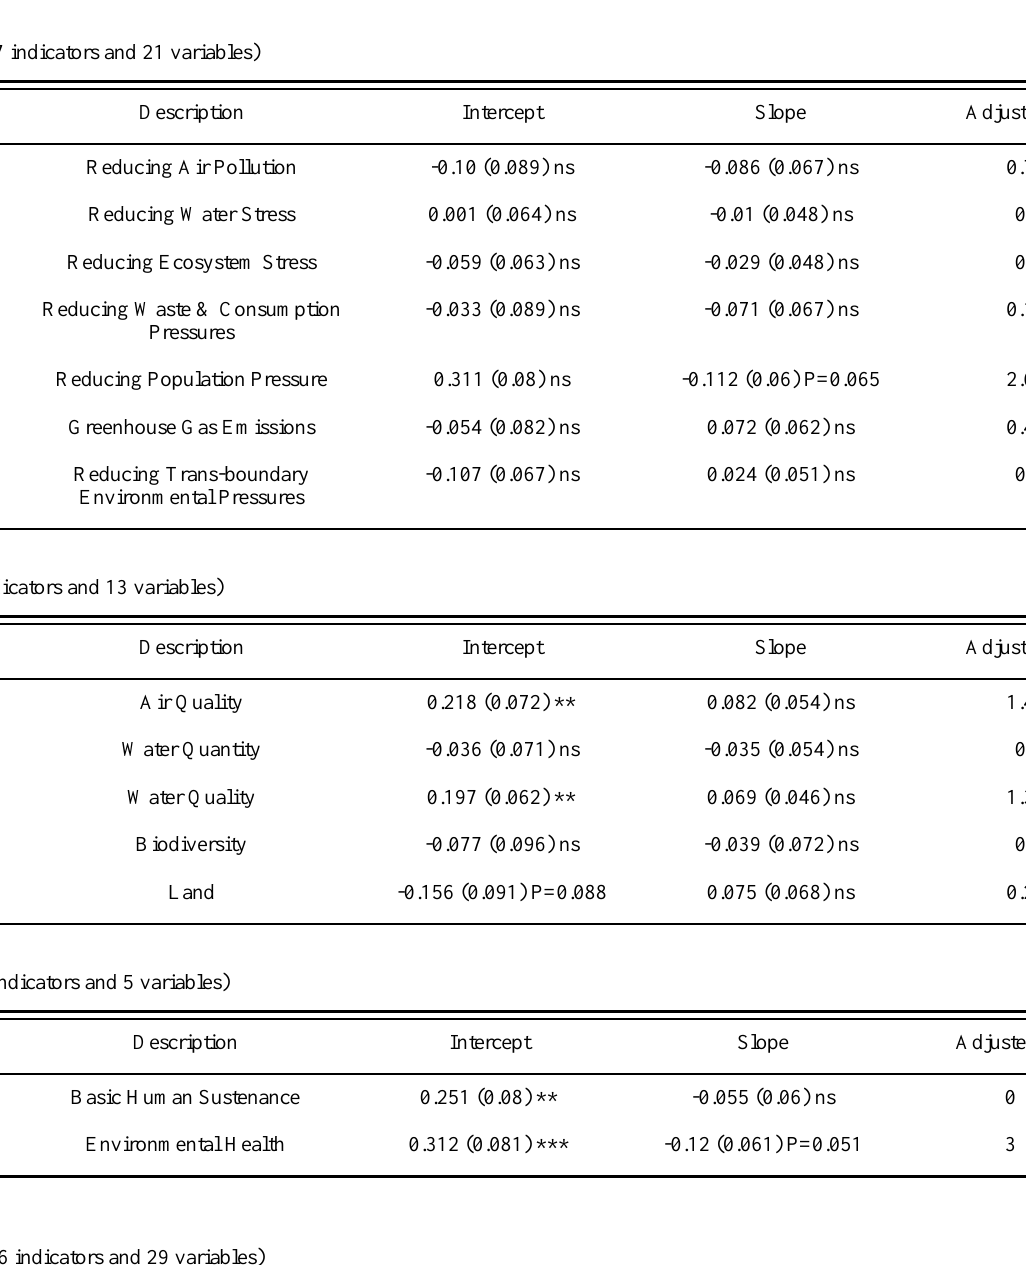
Table 6. Regression analysis with the PSIR indicators as dependent variables and residual CPI as the independent variable. Numbers shown are the t-values for the coefficients along with statistical